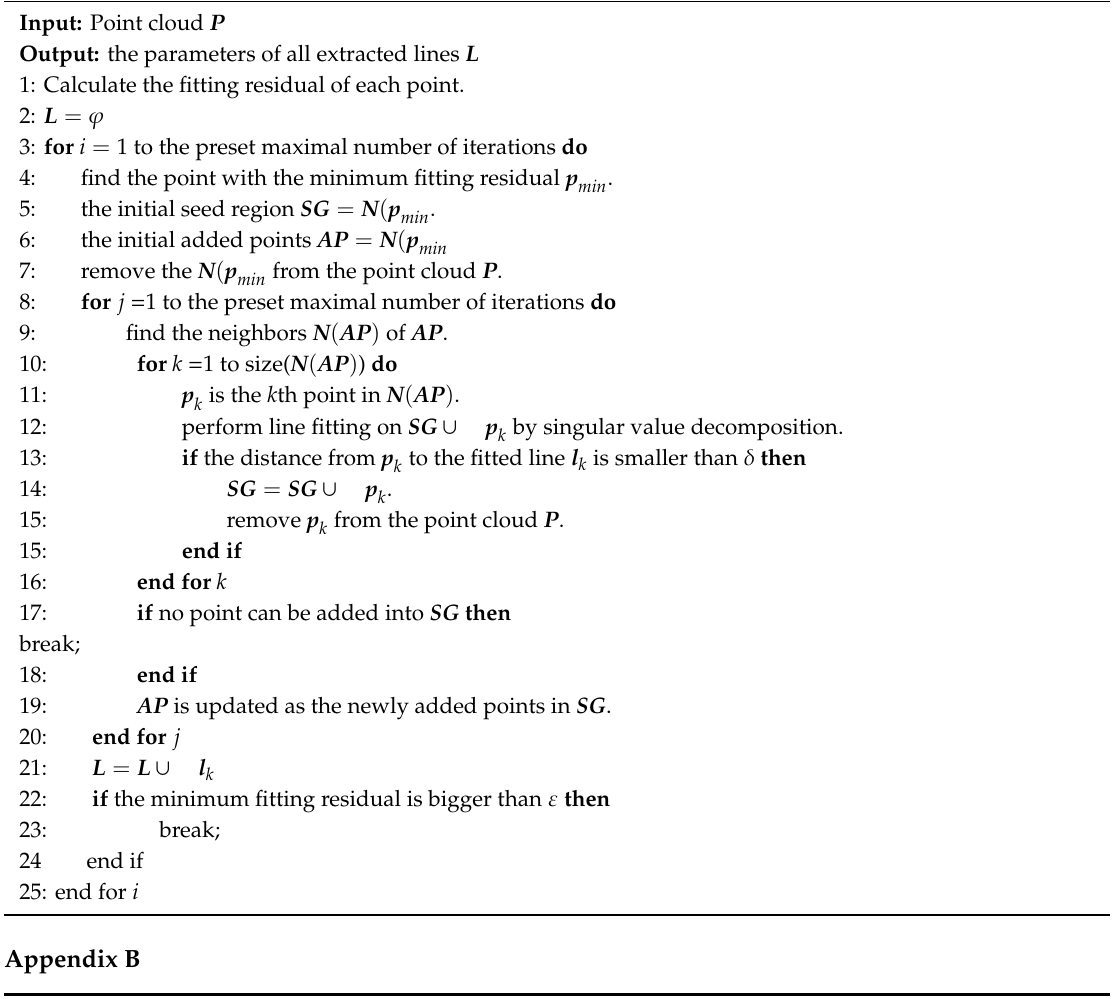
Algorithm 1: 2D line extraction